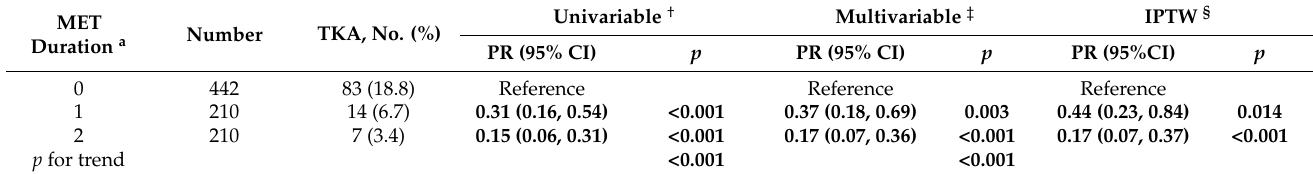
knee arthroplasty.